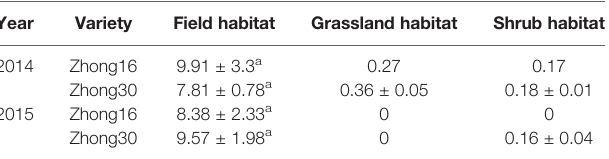
FIGURE 4 | The overall fi tness of cotton in grassland (II), and shrub (III) habitat relative to that of cotton in fi eld (I) habitat in 2014 and 2015. Data followed by the same lowercase letters are not signi fi cantly different at 0.05